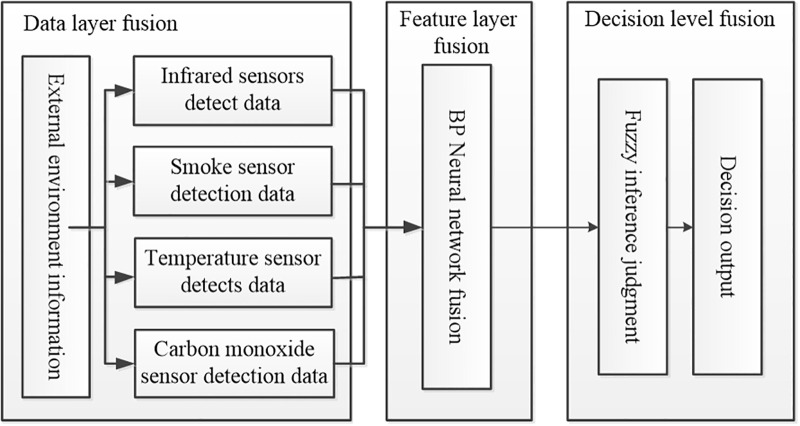
Block diagram of the multi-sensor information fusion system.